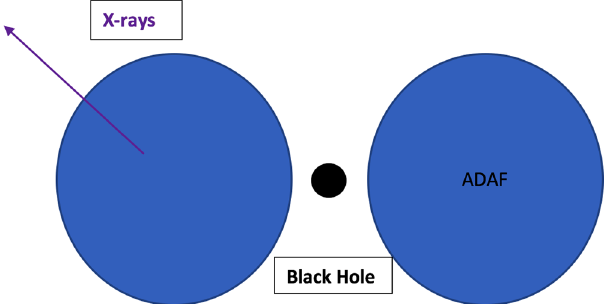
Figure 5. Hard X-ray emission from a radiatively inefficient accretion disk, characteristic of the top panel in Fig. 2b and the two top panels of Fig. 2c. The infrared dominated emission in the FRII HERGs of Fig. 2b,c give way to hard X-ray emission on timescales of order millions of